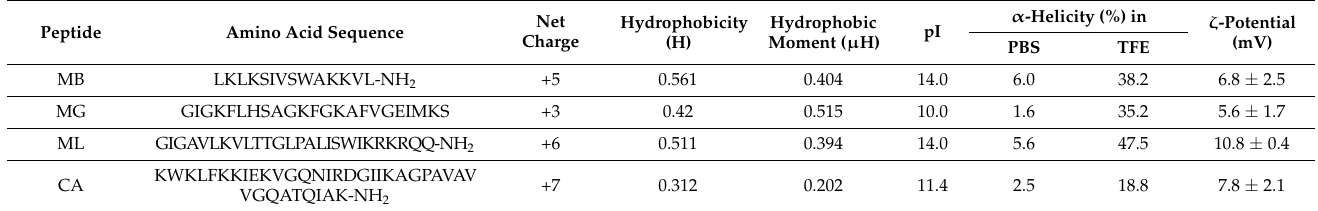
Table 1. Physicochemical properties of prolific pore-forming peptides.